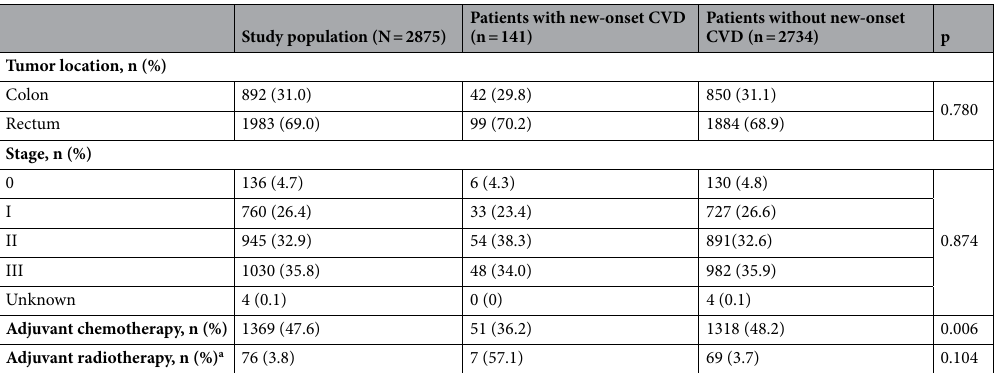
Table 2. Clinical characteristics of the patients. a Frequency was calculated in patients with rectal cancer.